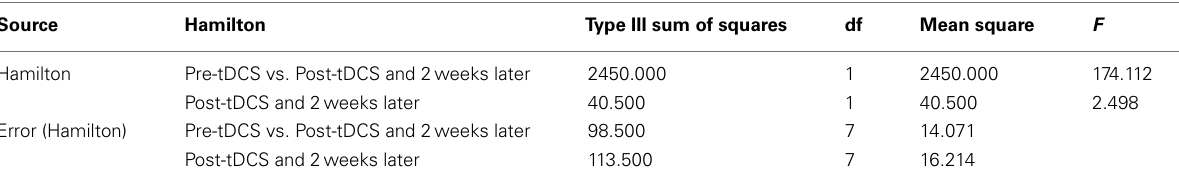
Table 1 |Tests of within-subjects contrasts for HAM-D.